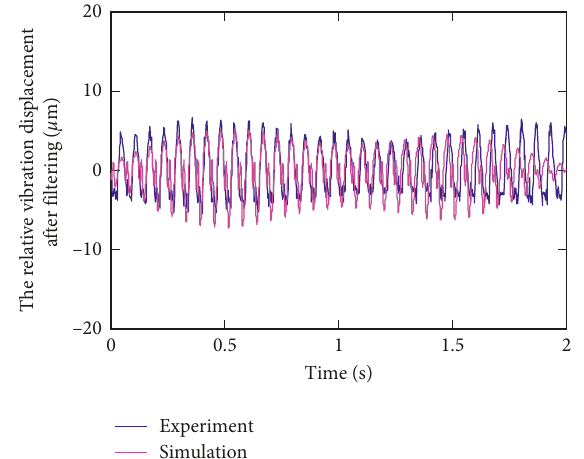
Figure 20: Mesh frequency component of quasistatic transmission error.